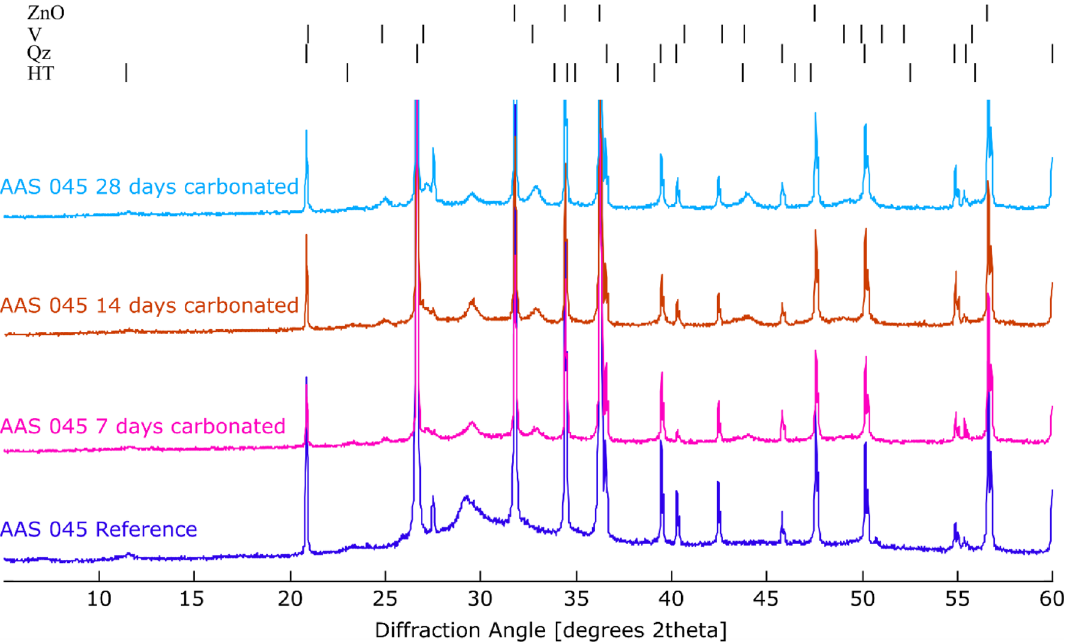
Figure 3. XRD diffractograms of specimen AAS 045 in a reference state and after each stage of carbonation. ZnO zincite internal standard, V vaterite, Qz quartz, HT